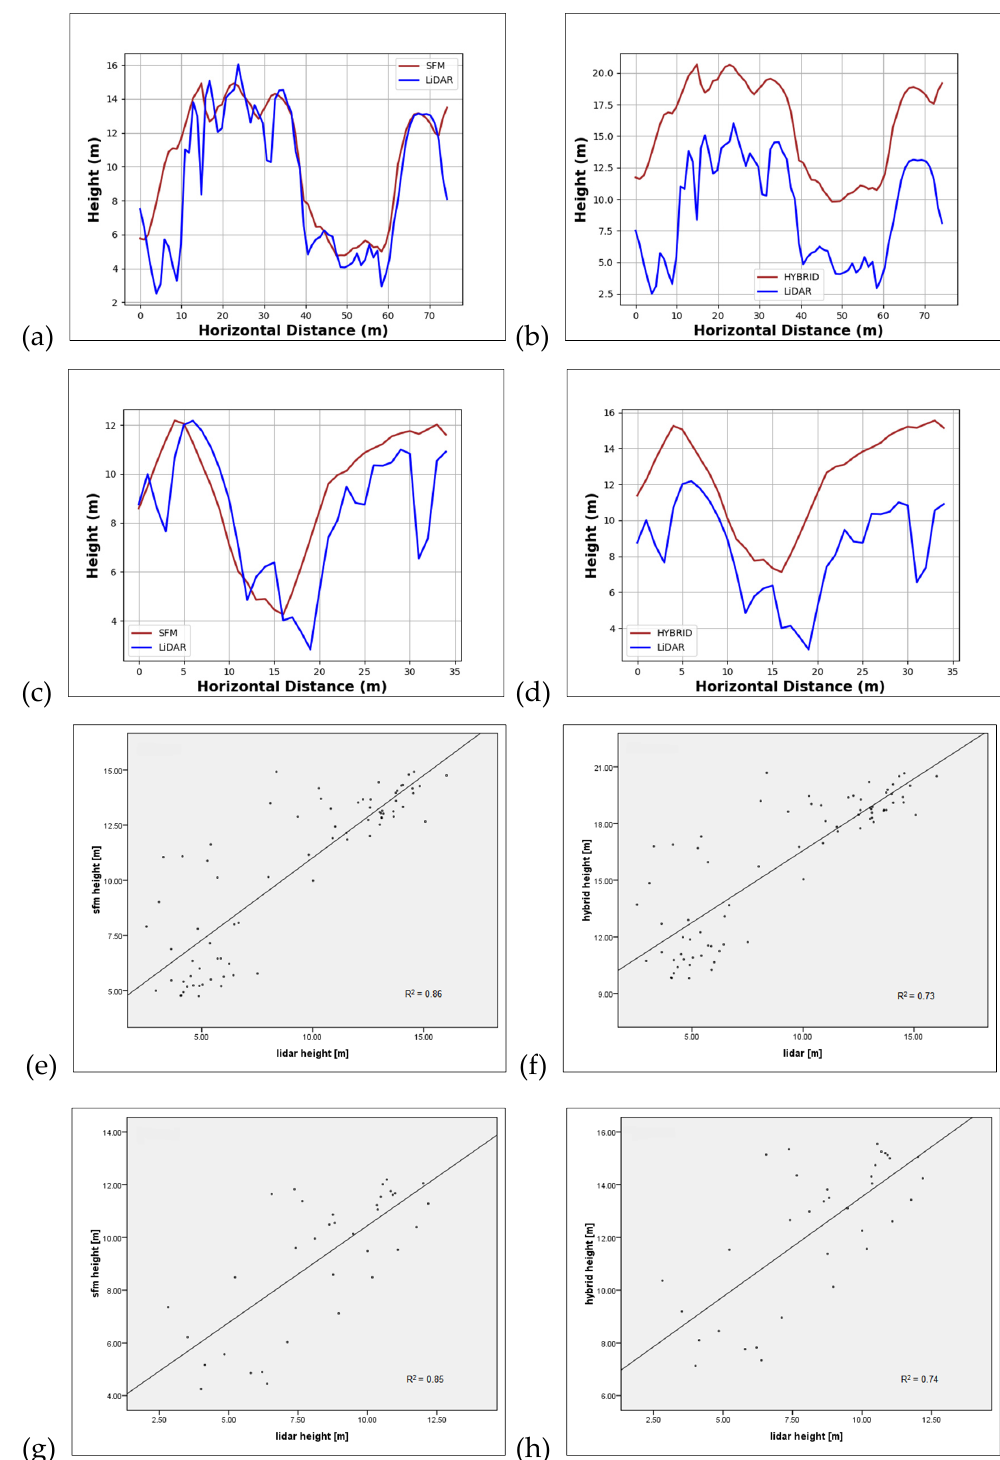
Figure 11. Showing for the Meshaw site; CHM profiles for ( a ) and ( b ) transect 2 and ( c ) and ( d ) transect 4, and corresponding regression plots ( e ) to ( h ). Both SfM and Hybrid CHMs showed strong positive correlation to LiDAR for both transects. However, the Hybrid heights constantly over ‐ estimated the tree heights in both cases.